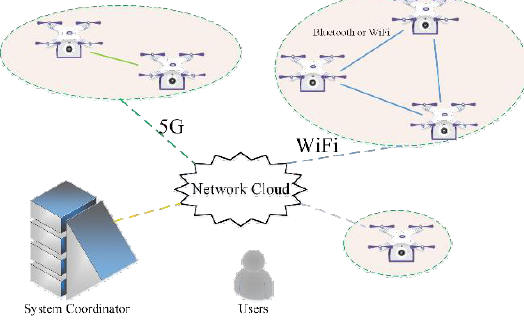
Figure 2. The UAV-based IoT platform we studied.